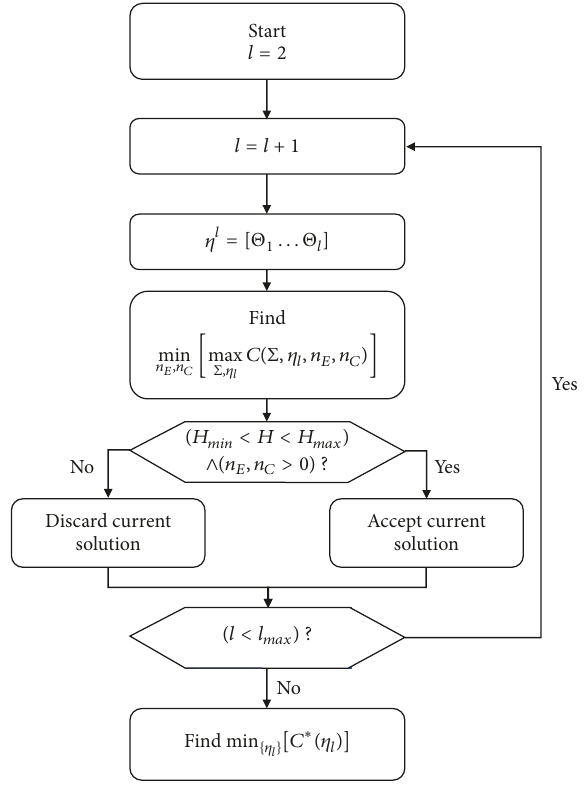
Figure 2: The proposed